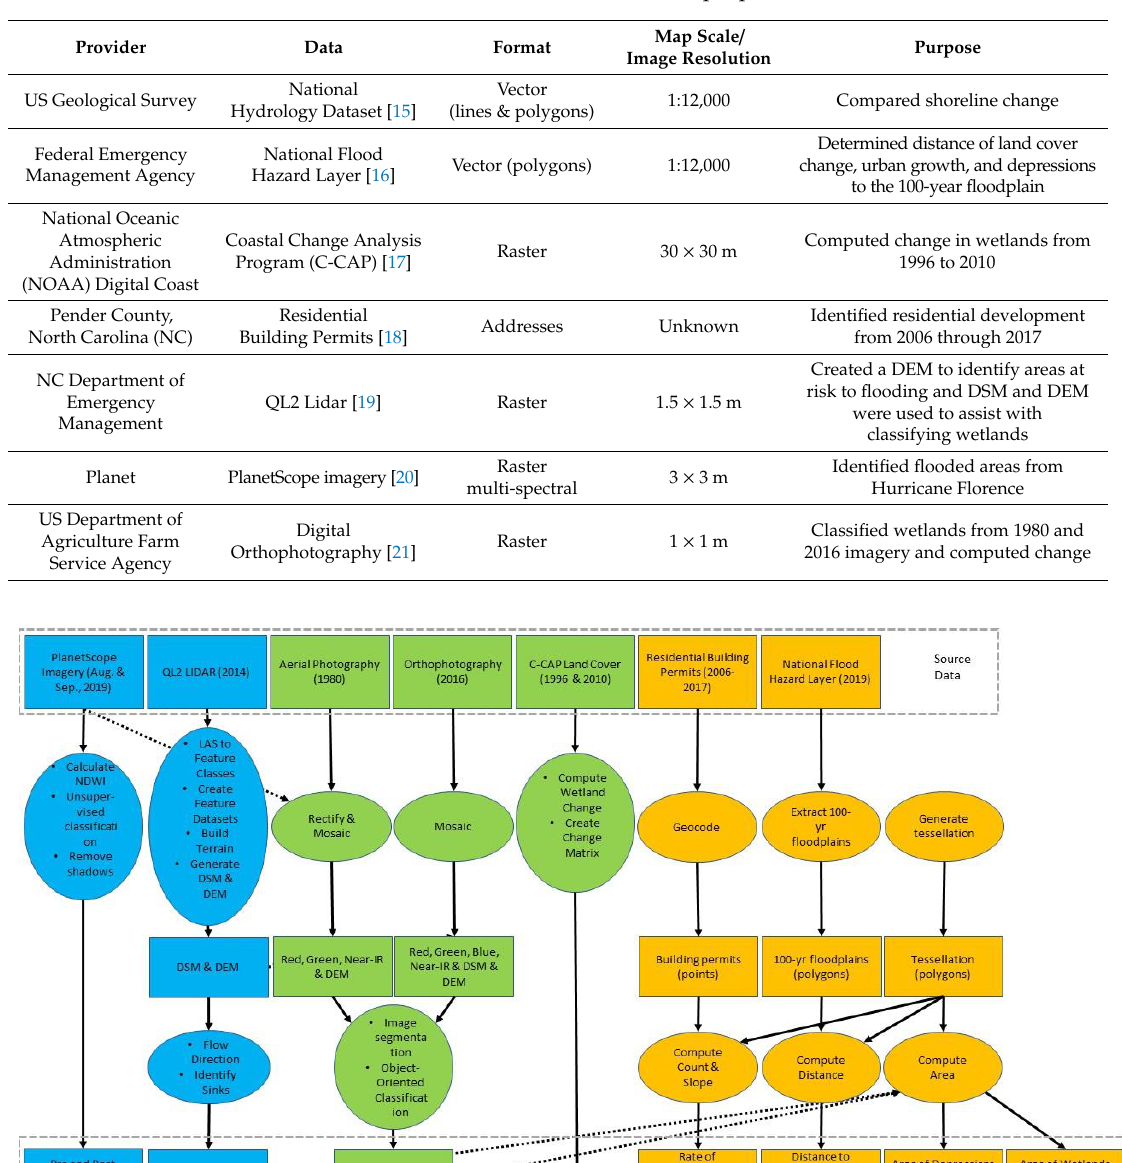
Table 1. List of data sources and their purpose.